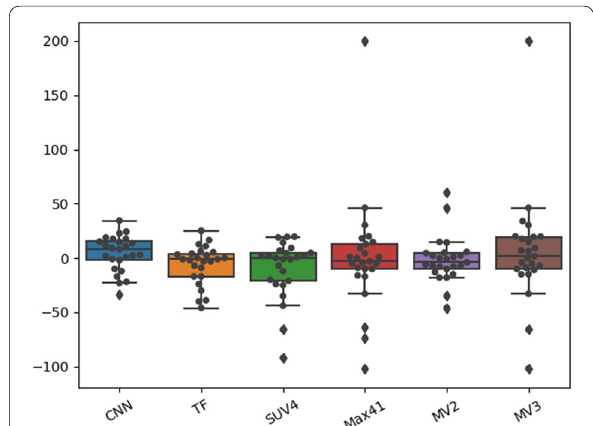
Fig. 6 Test–retest coefficient (TRT%) for all segmentation approaches: If the TRT% is close to 0, the repeatability of the segmentations is excellent. Abbreviations of the segmentation